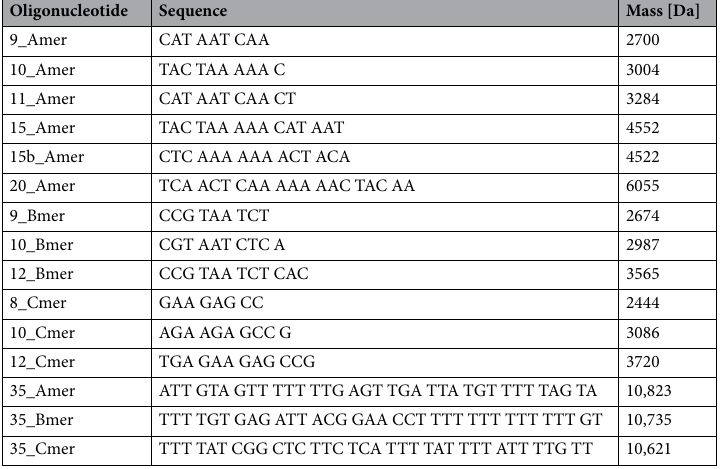
Table 1. Sequences and masses of DNA oligonucleotides used.